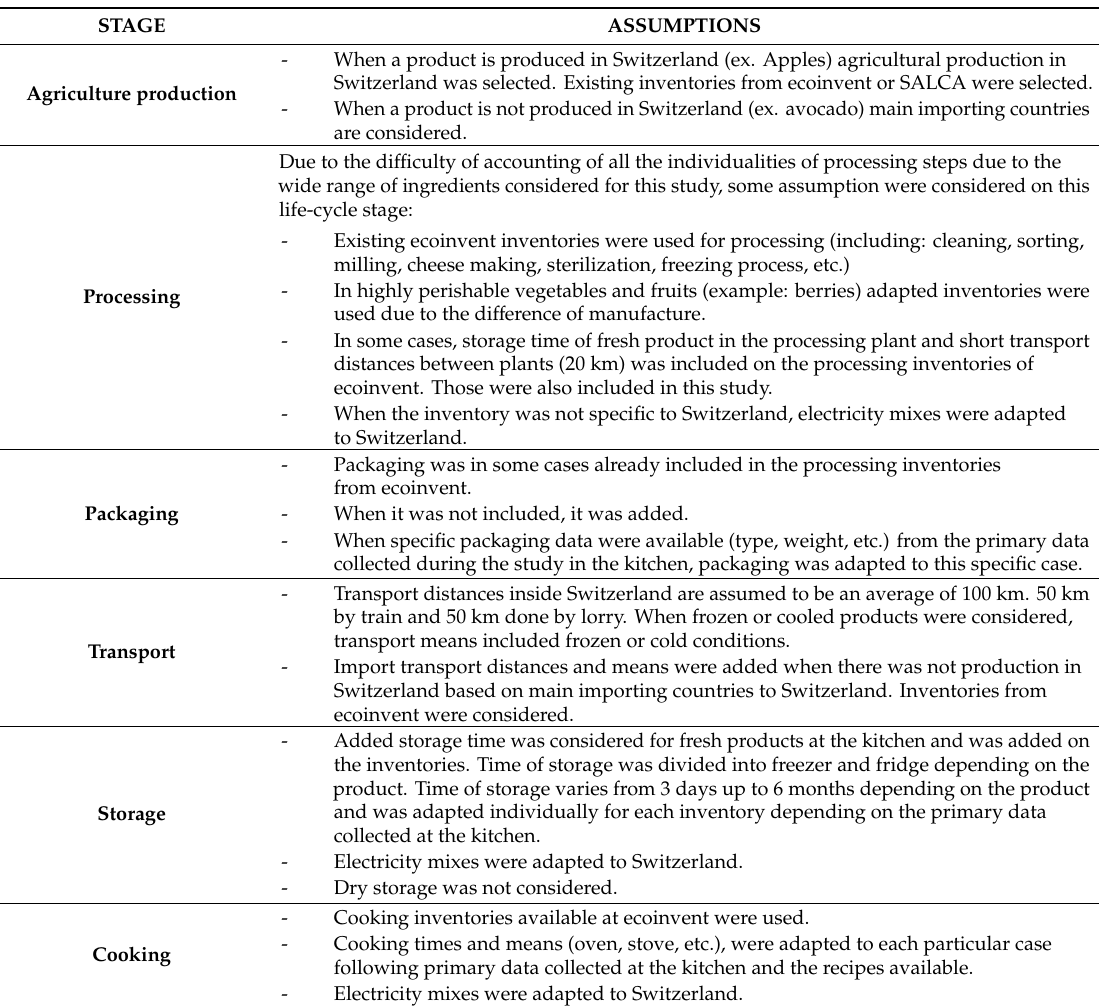
Table A2. Athlete’s Plate study LCA Assumptions.